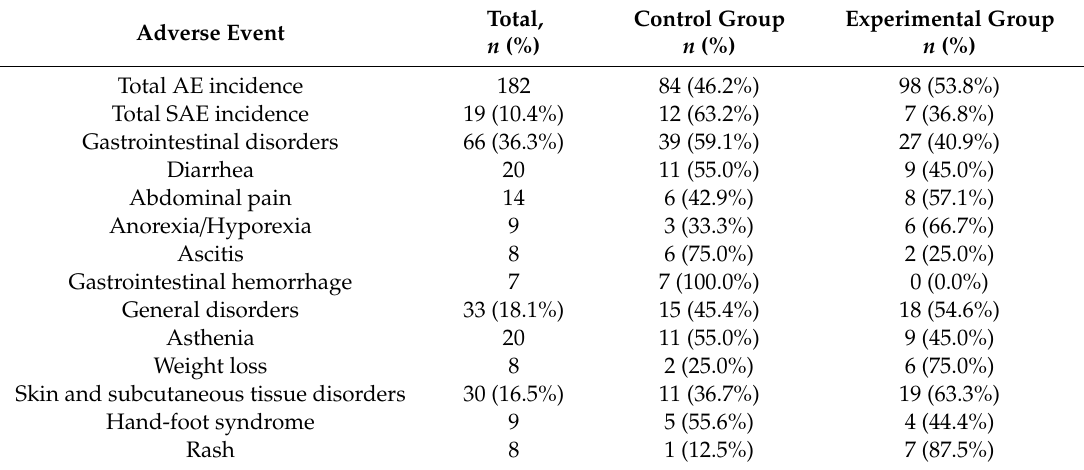
Table 2. Incidence of adverse events with a frequency ≥ 4% in the study